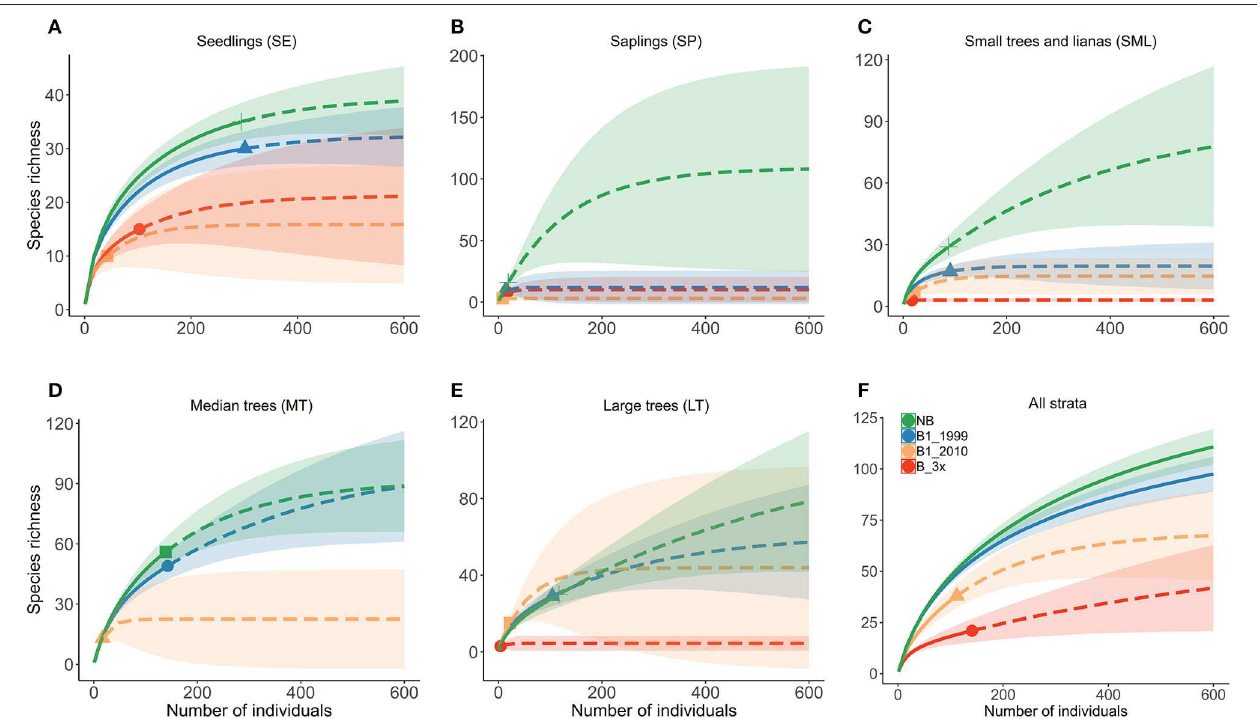
FIGURE 3 | Diversity estimates for all vegetation strata for different fire frequency and time since burned [NB, B1-1999, B1-2010, and B-3x (2006, 2010, and 2013)]. Analyses were conducted separately for each vegetation strata (A) SE, (B) SP, (C) SML, (D) MT, and (E) LT, and (F) for all strata together. LT stands for adult trees, MT to medium trees, SML for small trees and woody lianas, SP for saplings and SE for seedlings. Continuous and dashed lines refer to observed and extrapolated sample coverage, and the area around the curve represents a 95% confidence